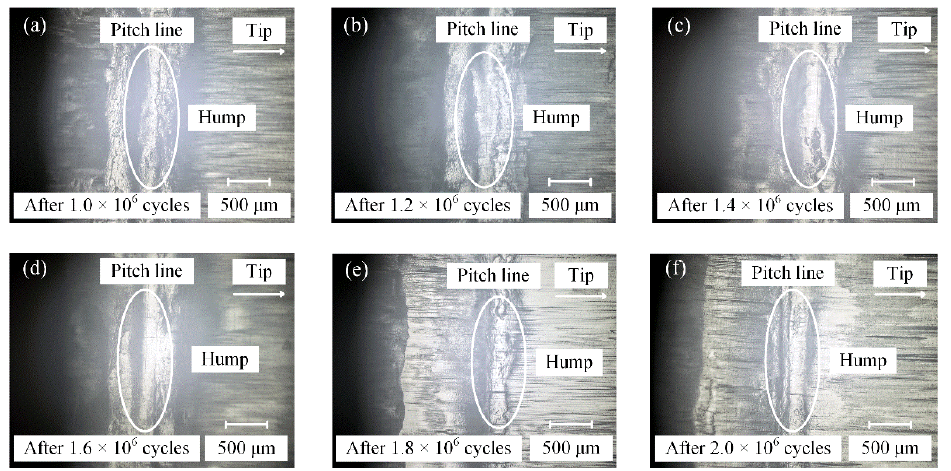
Fig. 11 Evolution of the second gully under the dry running condition.